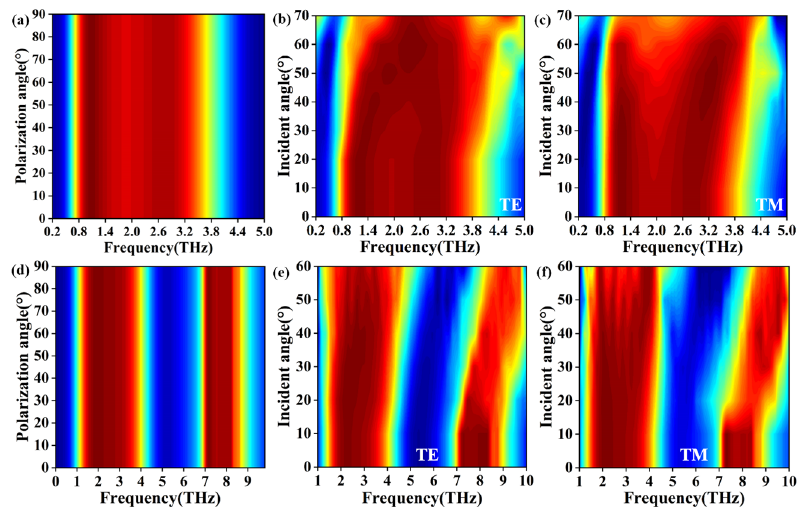
Figure 7. ( a ) Single-broadband absorption spectrum with changing plane wave polarization angle; ( b ) TE and ( c ) TM polarization with single-broadband absorption at different incidence angles; ( d ) Double-broadband absorption spectrum with changing plane wave polarization angle; ( e ) TE and ( f ) TM polarization with dual-broadband absorption at different incidence angles.